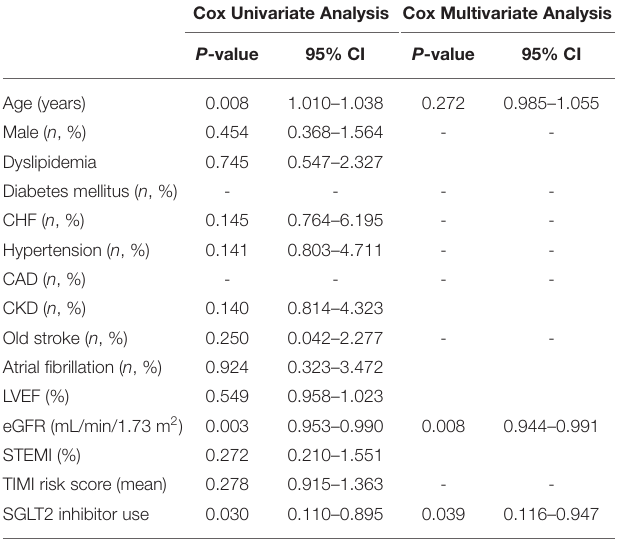
TABLE 3 | Univariate and multivariate analyses of adverse cardiovascular